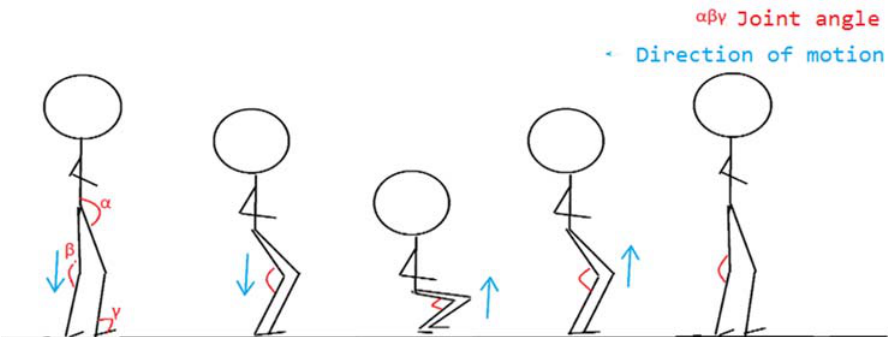
Figure 8. Squatting action decomposition.